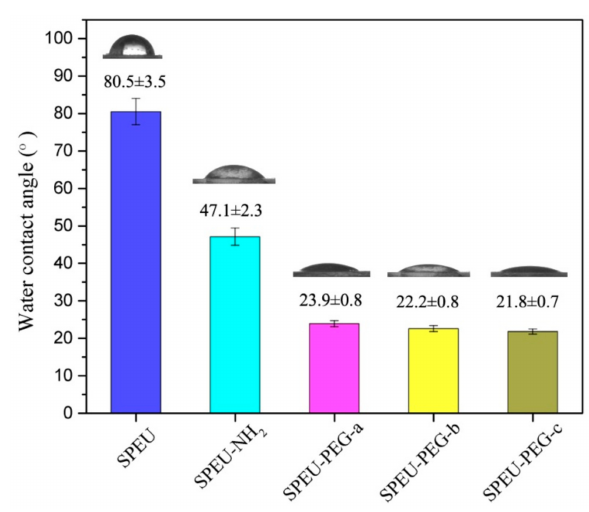
Figure 6. Water contact angle and images of the blank and modified SPEU films.